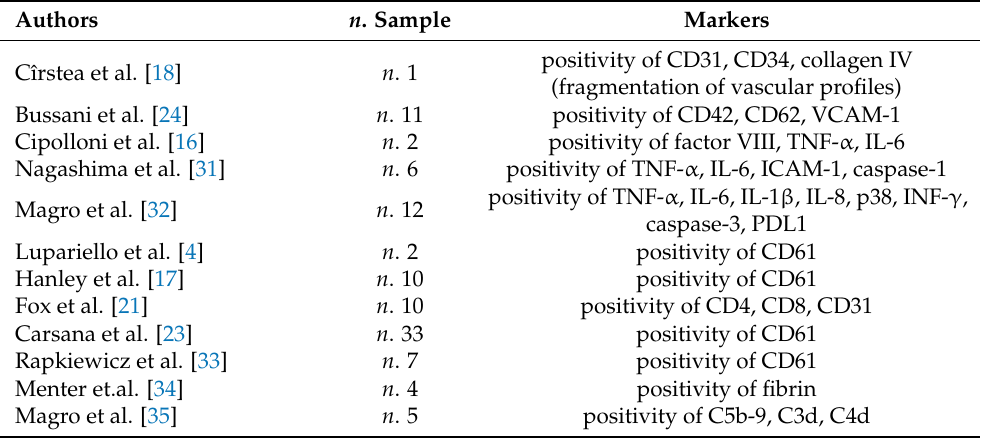
Table 2. Summary of immunohistochemical marker for lung endothelial damage and thromboem-